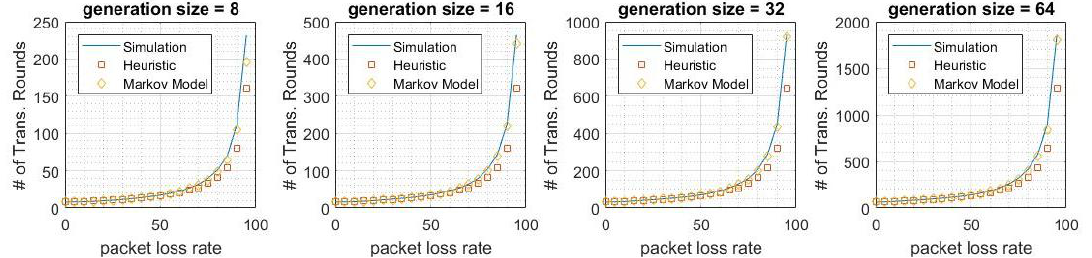
Figure 5. Average number of transmission rounds in cache